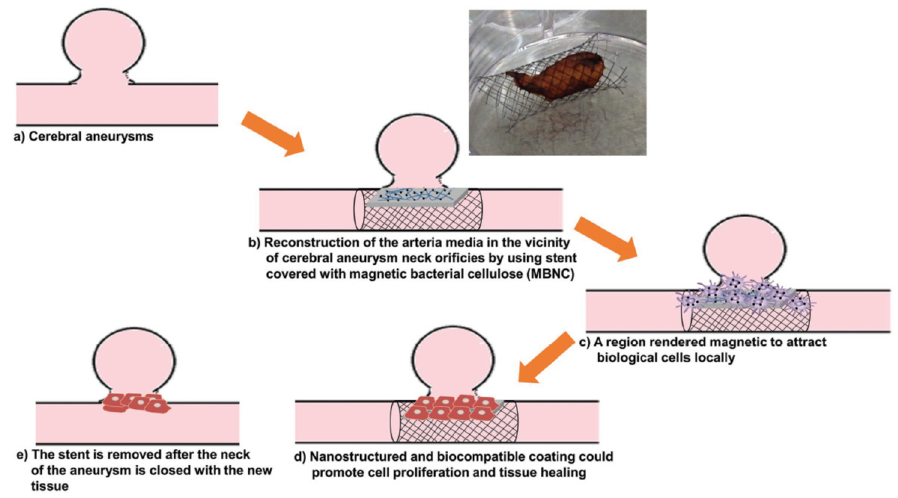
Figure 8. The schematic presentation of the concept of endovascular treatment at the neck orifice in cerebral aneurisms ( a ). The process consists of arterial media reconstruction by using a stent covered with the magnetic bacterial nanocellulose (MBNC) ( b ) designed to attract cells to the aneurysm region ( c ). With time, new tissue grows over the stent, closing the neck of the aneurysm ( d ) and ultimately, the removal of the stent ( e ). The photographic image of the Nitinol stent covered with MBNC revealed their good adhesion to the stent [ 174 ] . Copyright 2017 John Wiley & Sons Inc. Reproduced with permission.